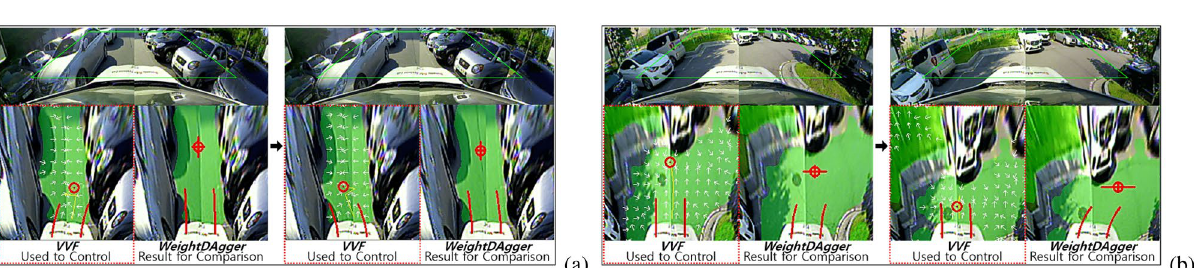
Figure 11. The vehicle using tentacle did not drive in the middle of the drivable area and did not avoid obstacles safely. The blue lines in the tentacle image represent the candidate paths. The red line represents the selected path to track.